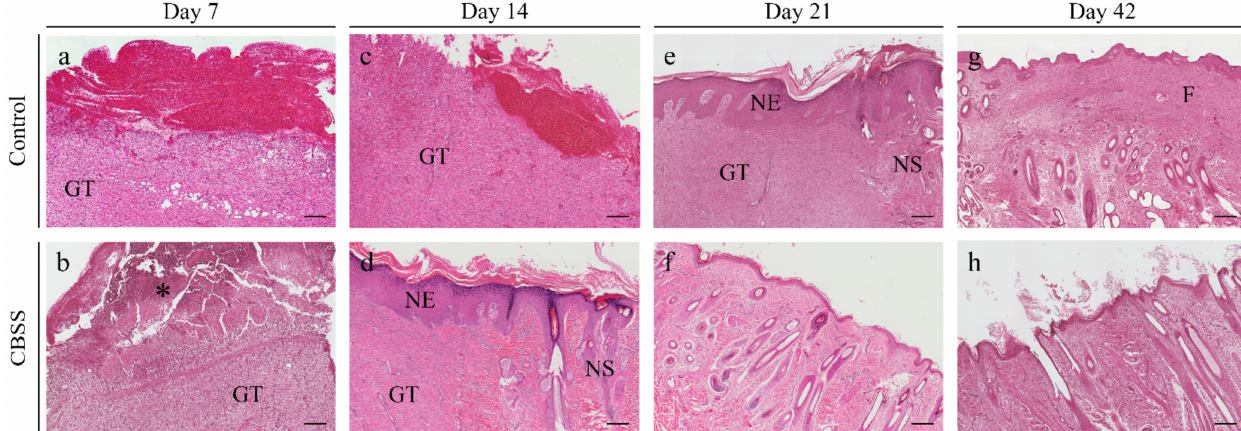
Figure 5. Histopathological microphotographs of skin biopsies at different time points after wounding: control and CBSS-treated wounds comparison. ( a , b ) Skin wounds at 7 days, in the CBSS-treated wounds (b) is possible to appreciate the presence of the 3D scaffold; ( c , d ) wounds at 14 days, treated wounds started to show a neoepidermis (NE, characterized by an hyperplastic appearance) and skin adnexa; ( e , f ) wounds at 21 days after wounding; ( g , h ) wounds at 42 days. GT = granulation tissue; NE = neoepidermis; NS = neoskin; F = fibrosis; asterisk = 3D sponge-like scaffold. Scalebar = 200 µ